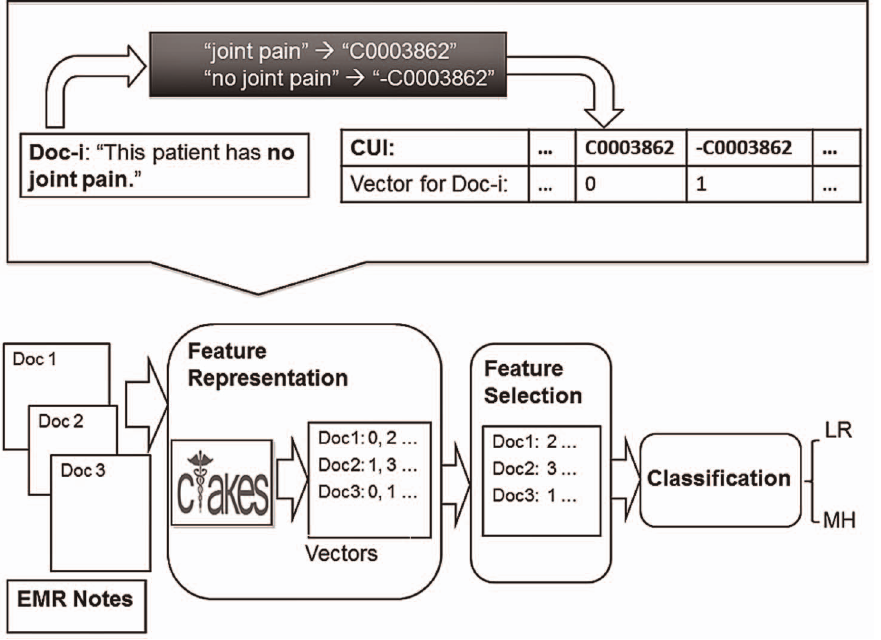
Figure 1. Representation of the processing flow for automatic disease activity labeling. Abbreviations: CUI – Unified Medical Language System Concept Unique Identifier; cTAKES – clinical Text Analysis and Knowledge Extraction System; LR – Low/Remission disease activity; MH – Medium/High disease activity; EMR – Electronic Medical Record.